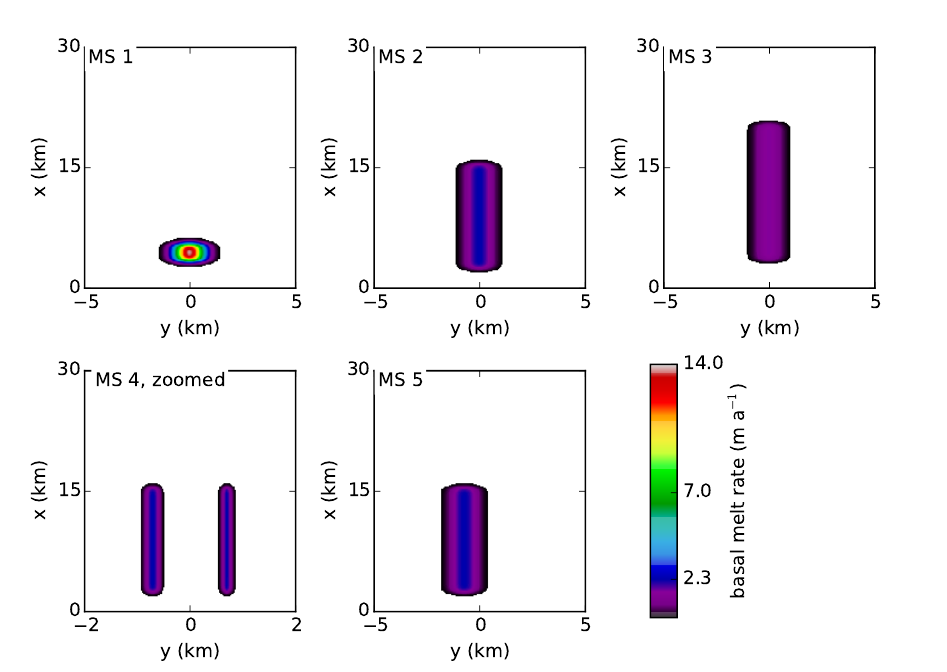
Figure 2. Visualization of melt scenarios MS1–5 detailed in Table 1.